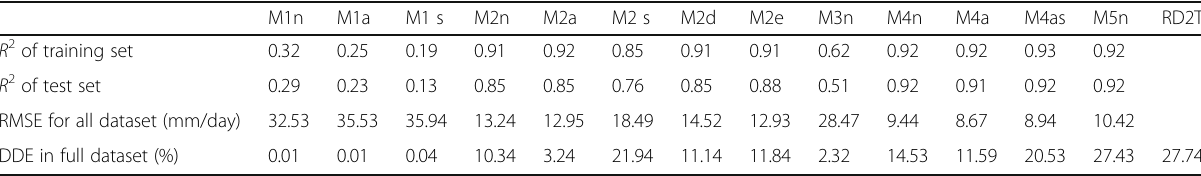
Table 7 RMSE and R 2 for training and test sets of different ANN model configurations